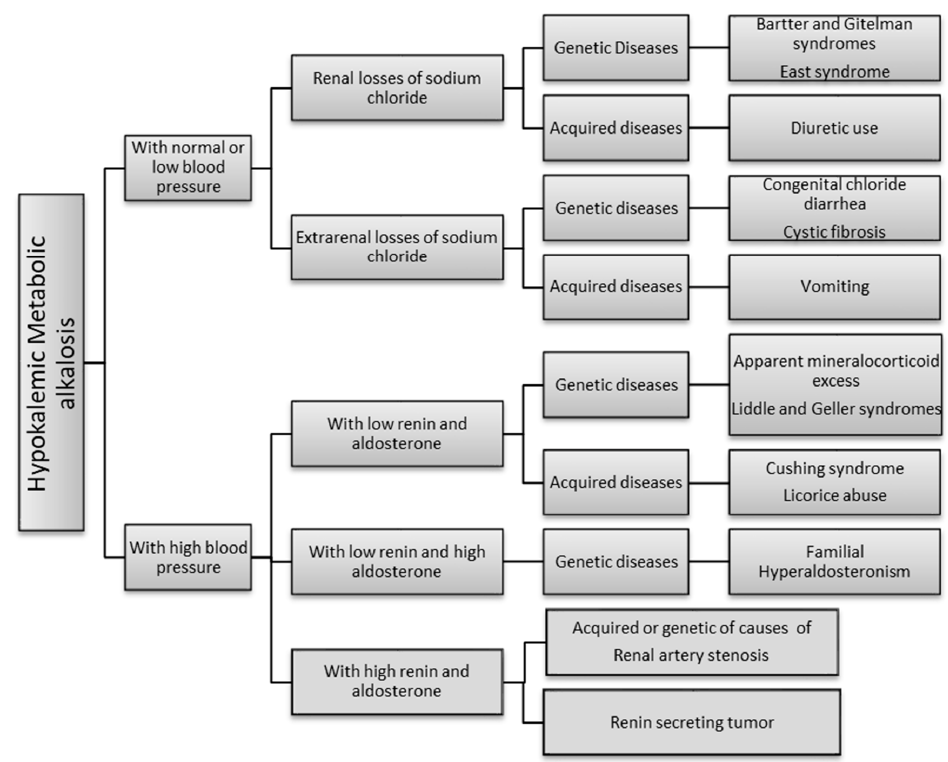
Figure 1. Algorithm of the causes of hypokaliemic metabolic alkalosis. Most of these disorders are rare, with a potentially insidious clinical presentation and diagnosis is often delayed or missed [7,8]. In addition, age at onset can be variable, with the most severe forms usually being detected in early childhood.